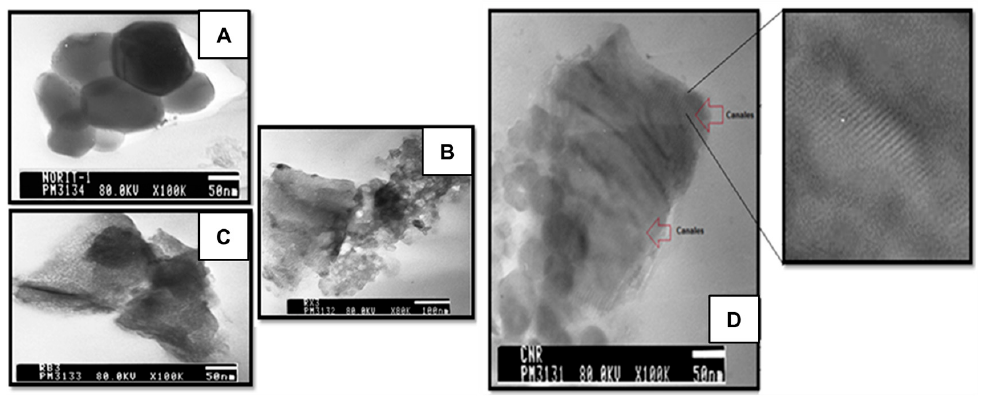
Figure 5. Transmission electron microscopy (TEM) images of AC supports: ( A ) G60; ( B ) RX3; ( C ) RB3; and, ( D ) CNR.